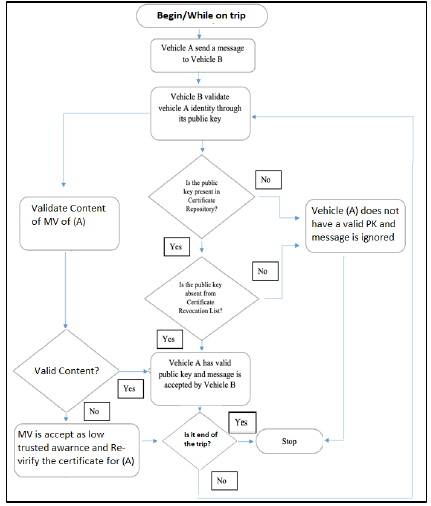
Fig. 6. Validating Vehicles Before Accepting Message